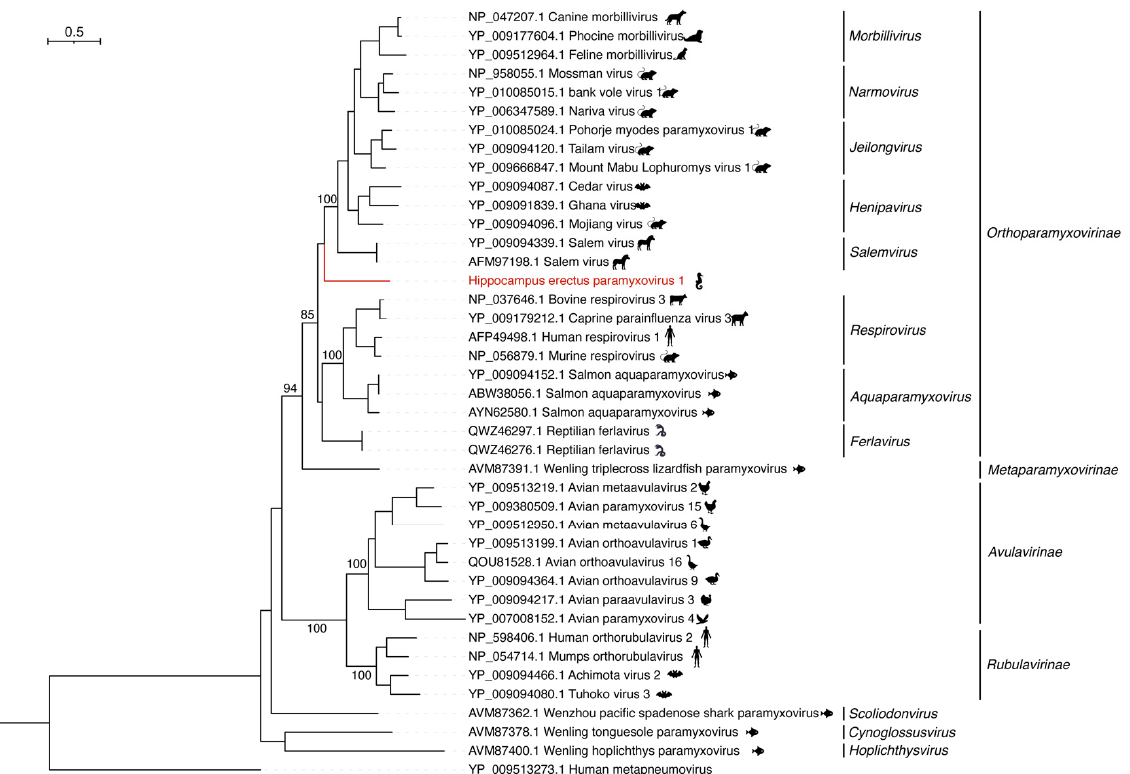
Figure 3. Phylogenetic analysis of the RdRp sequences of HePmV1 and representative paramyxoviruses. Phylogenetic analysis was performed using IQ-TREE, with the best-fit model LG + F + R5 and 1000 bootstrap replicates. Only bootstrap values >80% were shown.